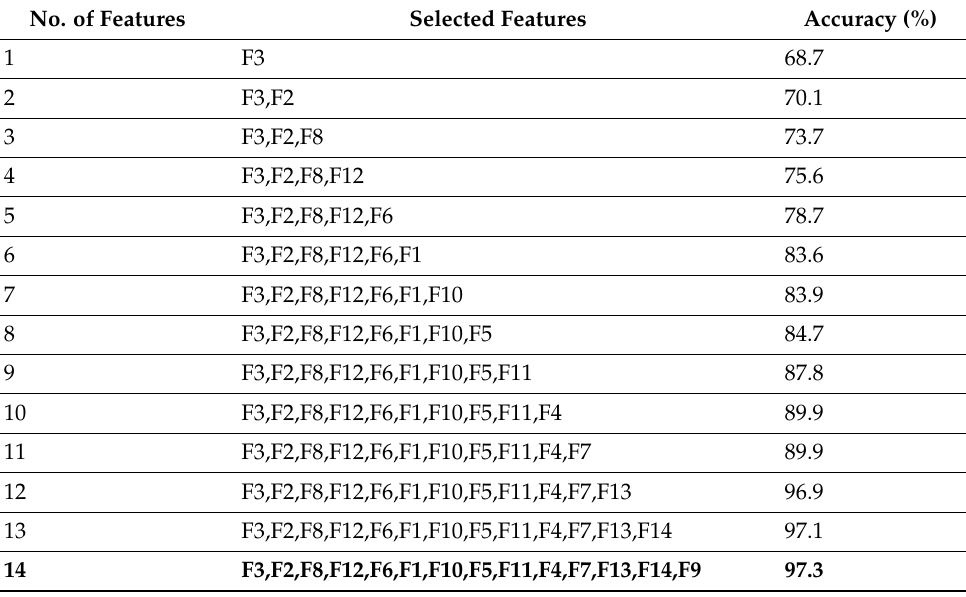
Table 7. Performance of fault detection using SFS with SVM (five-fold cross-validation).